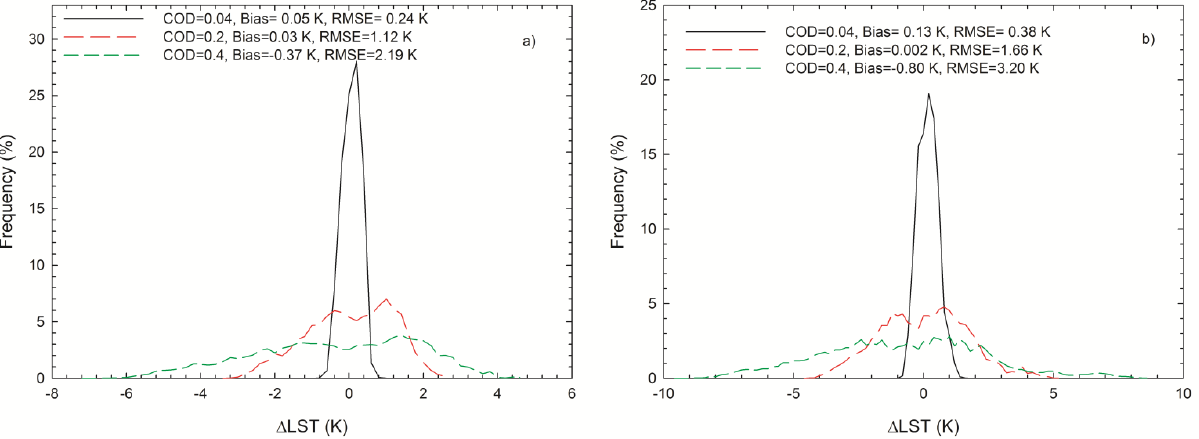
Figure 6. Histograms of LST errors after correction (  LST  T COD − k * COD ) with a COD (at 0.55 μm) = 0.04, 0.2 and 0.4 for ( a ) VZA = 0° and ( b ) VZA =